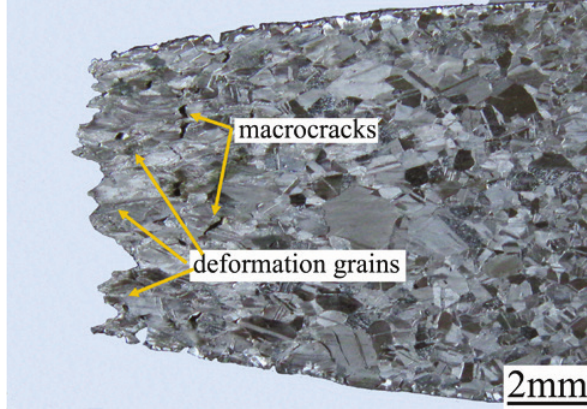
Fig. 7: Macrographs of longitudinal sections close to the fracture of alloy 2 at 900 °C